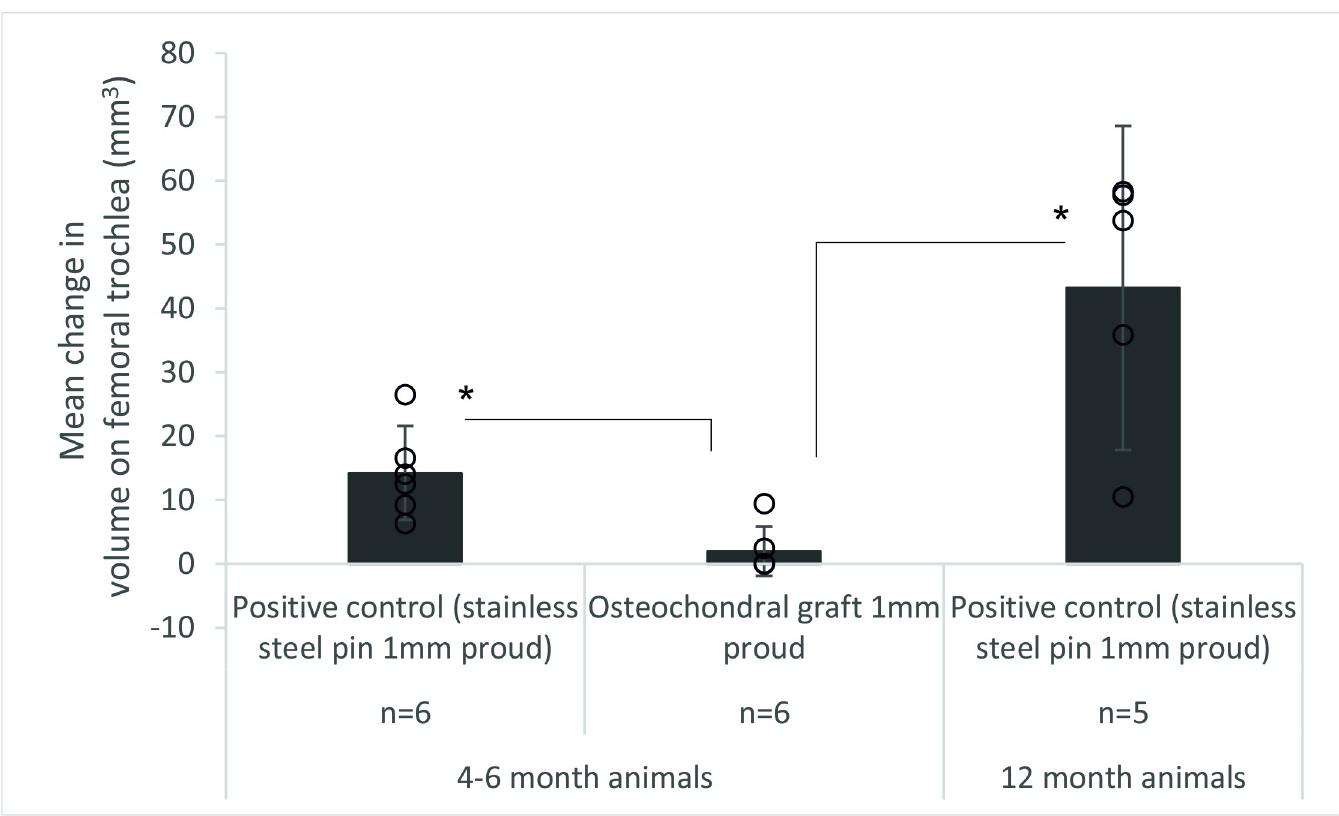
Fig 6. Mean ( ± 95% CL) volume (mm 3 ) of wear, deformation and damage in the cartilage on the femoral trochlea after 3 hours (10,800 cycles) simulation of grafts positioned proud of the patella, � denotes p < 0.05. 6. The data points from all experimental groups have been overlaid as a dot plot, for the osteochondral graft group, the wear volume was not measurable on some